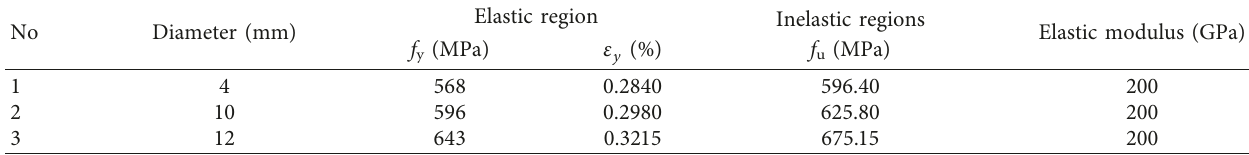
Table 3: Diameter and properties of steel reinforcements.